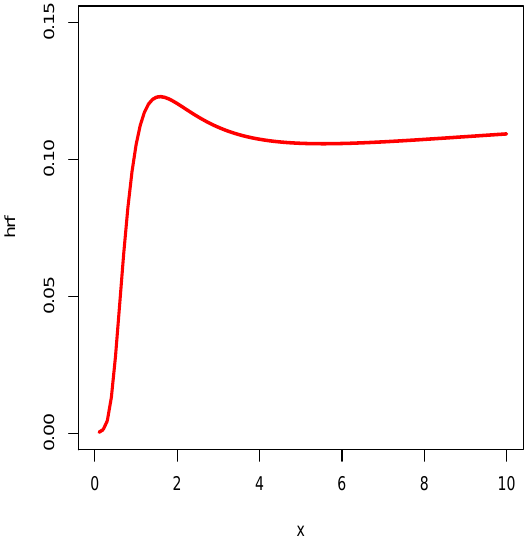
Figure 7. Estimated hrf of the EMIEE model for the COVID-19